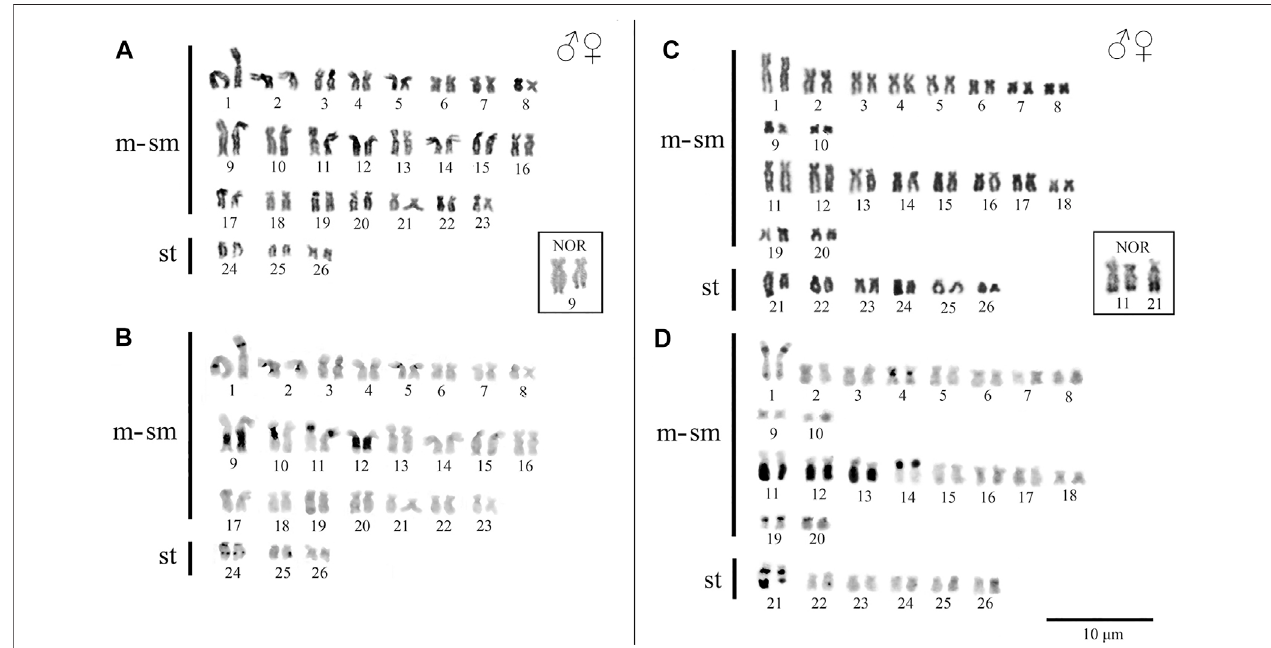
FIGURE 2 | Karyotypes of Peckoltia species. In (A) conventional staining and (B) C-banding of Peckoltia sp. 3 Jarumã; in (C) conventional staining and (D) C-banding of Peckoltia sp. 4 Caripetuba. In box the Nucleolus Organizing Regions (NORs).